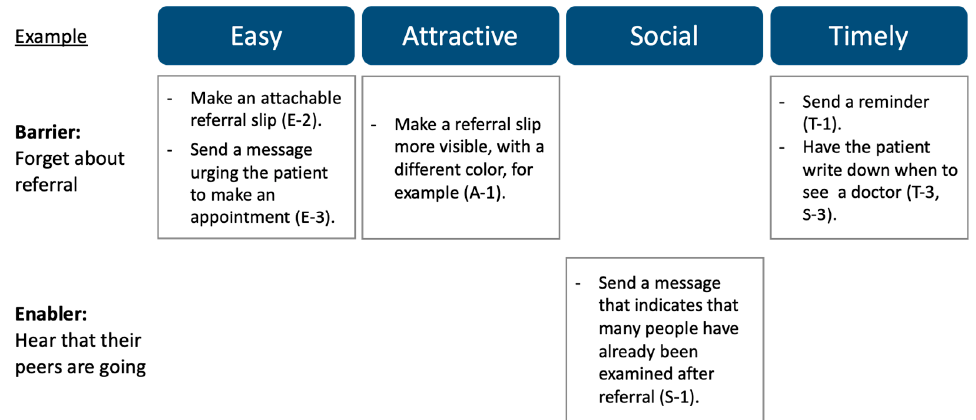
Figure 6. Use of the EAST framework for barriers and enablers: Example to increase attendance at the community health center following a medical referral based on screening.